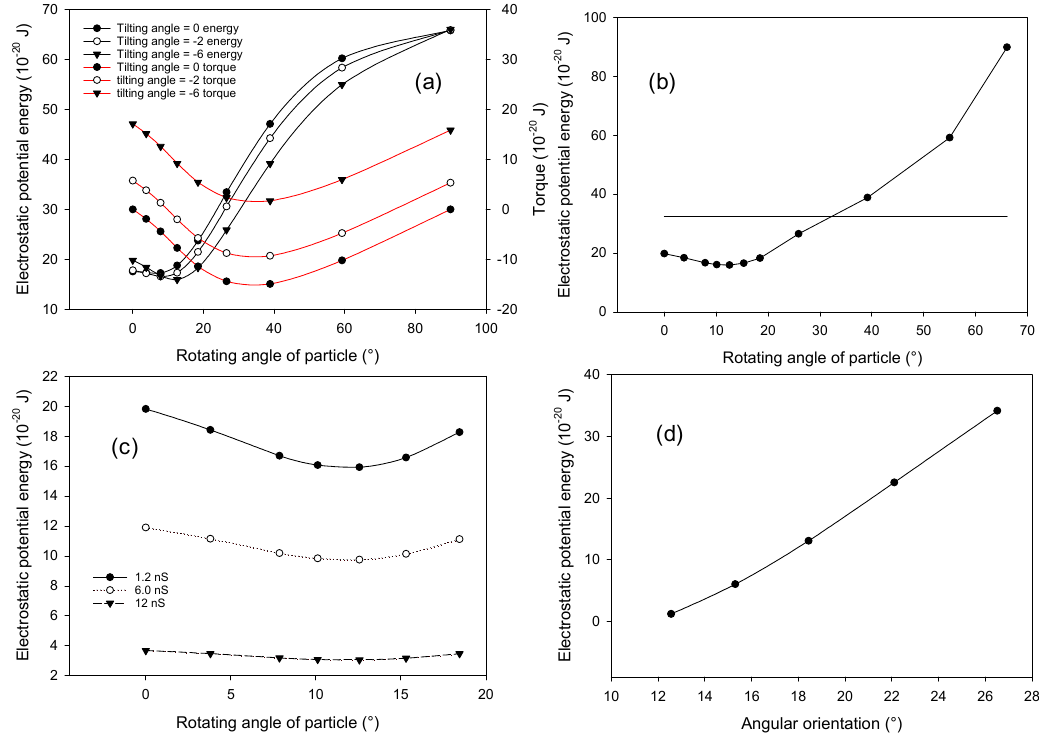
Figure 6. ( a ) Variation of electrostatic potential energy and torque of the middle ellipsoidal particle in three-particle pearl chain as the alignment angle increases from 0° to 90°, ( b ) Variation of electrostatic potential energy of the middle ellipsoidal particle in chain with respect to the alignment angle. The horizontal line represents the minimum energy of a single ellipsoidal particle. ( c ) Particles with different surface conductance have minimum electrostatic potential energy value around the same alignment angle. ( d ) Variation of electrostatic potential energy of the middle ellipsoidal particle in stacked configuration with respect to the diagonal chain angle.